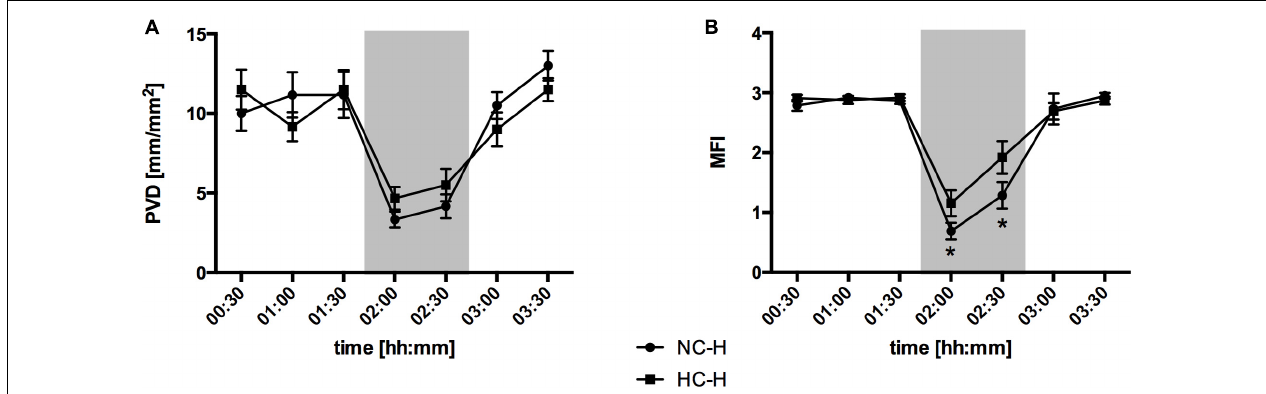
FIGURE 5 | Effect of local carbon dioxide application on microvascular perfusion variables: Perfused vessel density (PVD) in (mm/mm 2 ) (A) and Microvascular flow index (MFI) (B) at oral mucosa under hemorrhagic conditions. The animals received a continuous gas application with either N 2 to maintain local normocapnia (NC-H) or CO 2 for local hypercapnia (HC-H) followed by hemorrhage and retransfusion. One hour of acute hemorrhage is marked gray. Data are presented as mean SEM for n = 6 dogs; * p < 0.05 vs. control group (NC-H), 2-way ANOVA for repeated measurements followed by the Bonferroni post-hoc